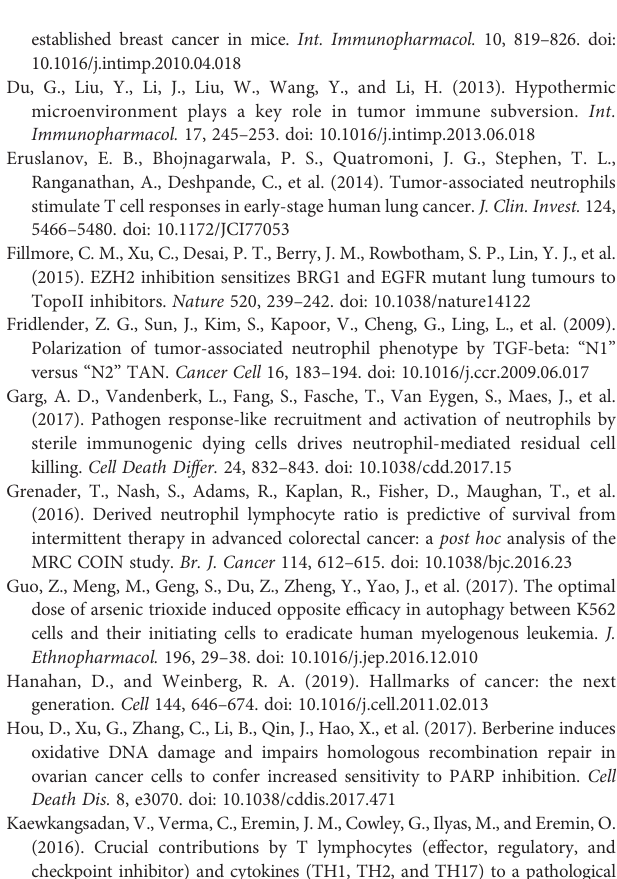
SUPPLEMENTARY FIGURE 5 | Serum Th1 cytokines and Th2 cytokines in tumor rechallenge immune study (n = 6). The data present Mean ± SD, the experiments were repeated 3 times, and statistical signi fi cance was determined by a t-test. *P < 0.05, **P < 0.01 vs control. DOX: Doxorubicin, BER: Berberine. SUPPLEMENTARY FIGURE 6 | KEGG enrichment analysis performed by DAVID and visualized by ehbio. SUPPLEMENTARY FIGURE 7 | GO enrichment analysis performed by DAVID and visualized by